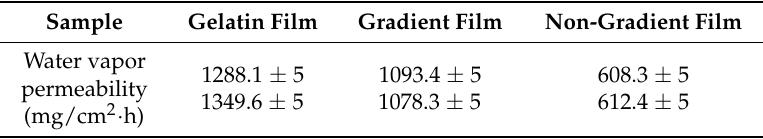
Table 1. Water vapor permeabilities of the gradient, non-gradient and gelatin